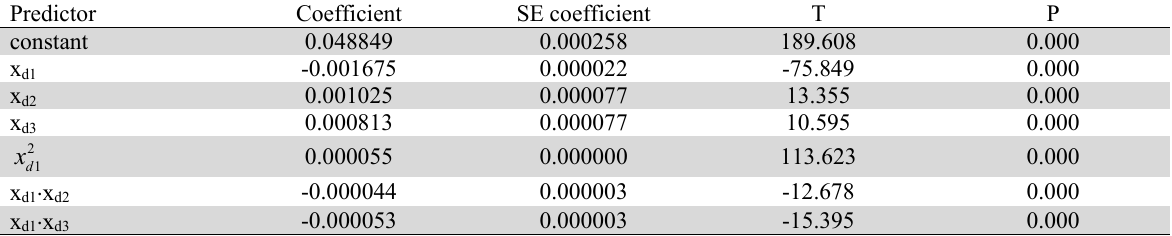
The MRA model for the prediction of strain energy density at chafer Predictor Coefficient SE coefficient T P